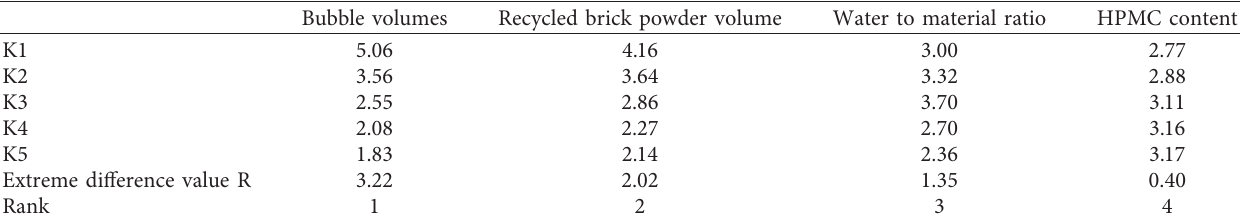
Table 9: Analysis of extreme differences in compressive strength of recycled brick powder foam